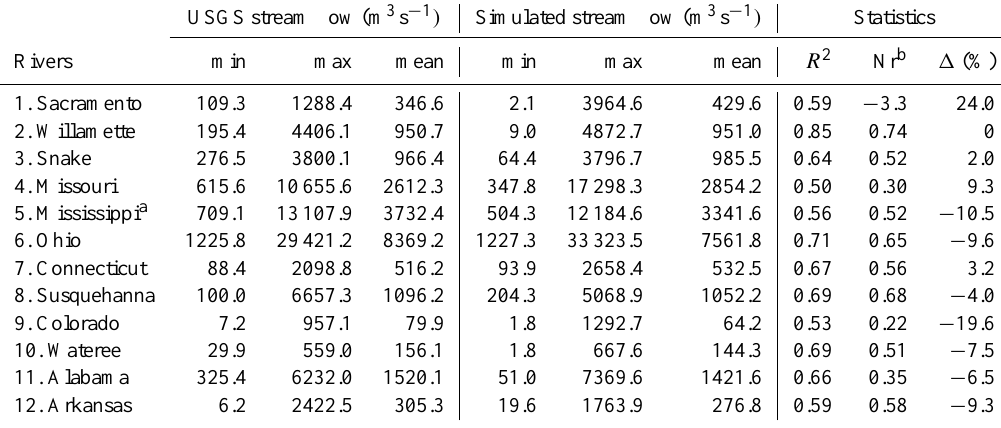
Fig. 8. Comparison between LH-simulated (red line) and US Geological Survey observed monthly stream flow (SF) (black line) at 12 river gage stations. Nr is the Nash-Sutcliffe coefficient. Table 6. Comparison between LH-simulated and observed stream flow for 12 major rivers in the